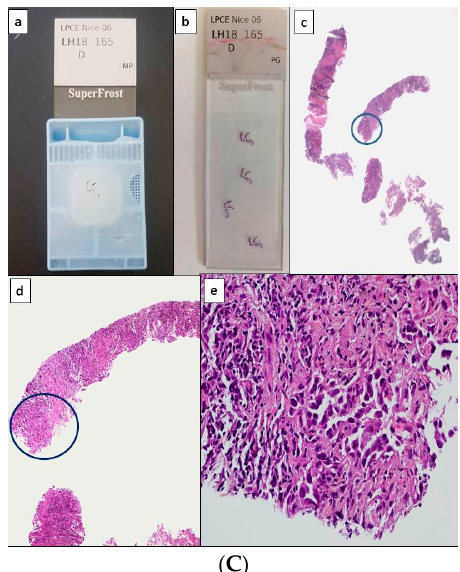
Figure 1. Potential scenarios for detection of theranostic biomarkers for lung adenocarcinomas using thoracic biopsies. Depending on the quantity of tumor cells detected on hematoxylin and eosin stained sections, immunohistochemistry (IHC) and/or molecular biology approaches can be used (with or without panels). ( A ) Large biopsy with a high percentage of tumor cells (more than 50%). Paraffin block with one biopsy ( a ) and corresponding 4 tissue sections stained with hematoxylin eosin ( b ). Different magnifications of the same tissue section showing high number of adenocarcinoma cells ( c – e ). In this latter case, the number of tumor cells should allow PD-L1 IHC to be performed first and then followed by NGS. Alternatively a workflow including successive PD-L1, ALK, ROS1, and BRAF IHC, and then NGS can be also adopted. ( B ) Small biopsies with a few tumor cells. Paraffin block with small biopsies ( a ) and corresponding 4 tissue sections stained with hematoxylin eosin ( b ). Different magnifications of the same tissue section showing in only one area (circle) a low number of tumor cells (no more than 15 tumor cells) ( c – e ). IHC targeting PD-L1, then IHC for EGFR, ALK, ROS1, and BRAF should be probably done. ( C ) Large biopsies with a low percentage of tumor cells (less than 5%). Paraffin block with at least 5 large biopsies ( a ) and corresponding 4 tissue sections stained with hematoxylin eosin ( b ). Different magnifications of the same tissue section showing in only one area (circle) some tumor cells ( c – e ). IHC for PD-L1 then successively for ALK, ROS1 and BRAF can be done and followed by targeted molecular biology for detection of EGFR mutations on a single tissue section or alternatively IHC for EGFR, according to the sensitivity of the MB test [1Ac, 1Bc, 1Cc, original magnification ×25; 1Ad, 1Bd, 1Cd, original magnification ×100; 1Ae, 1Be, 1Ce, original magnification ×400].